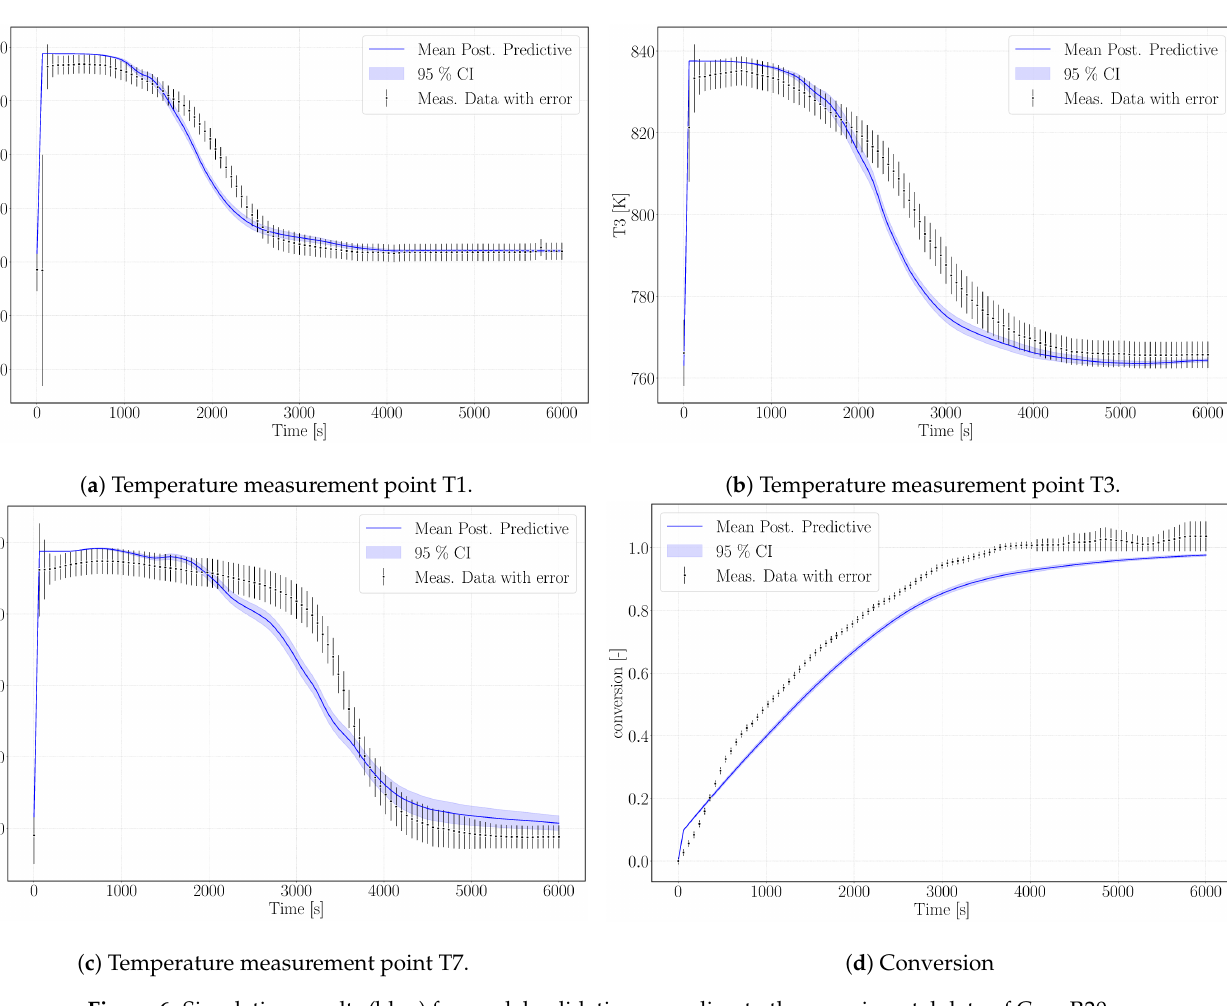
Figure 6. Simulation results (blue) for model validation according to the experimental data of Case